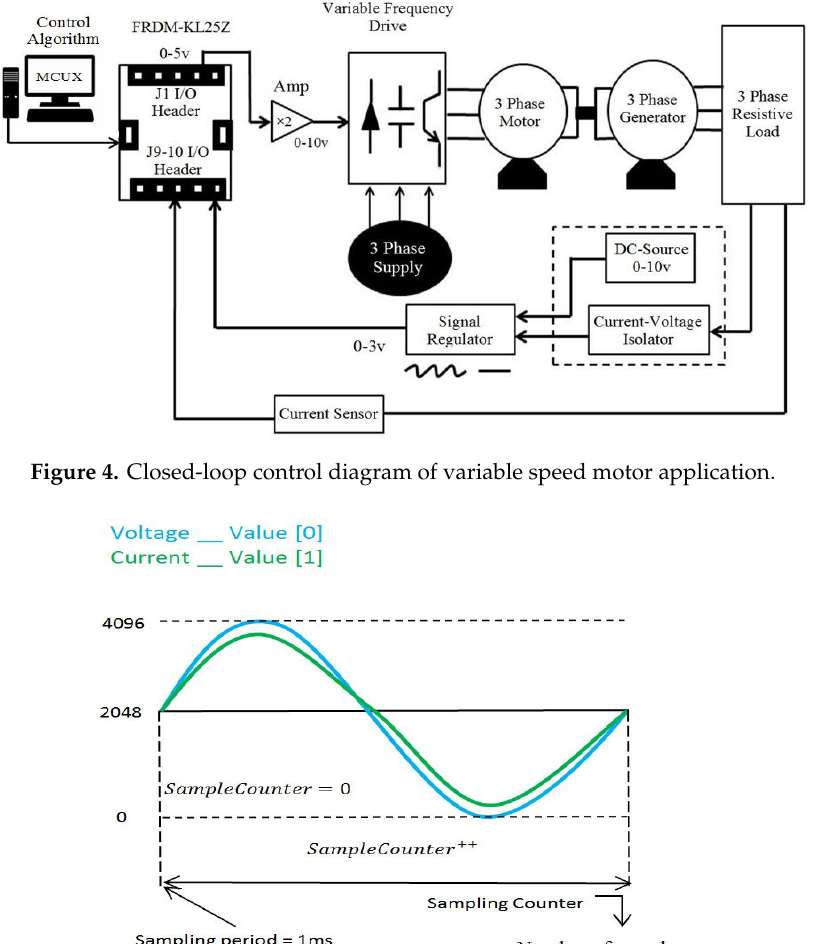
Figure 4. Closed-loop control diagram of variable speed motor application.